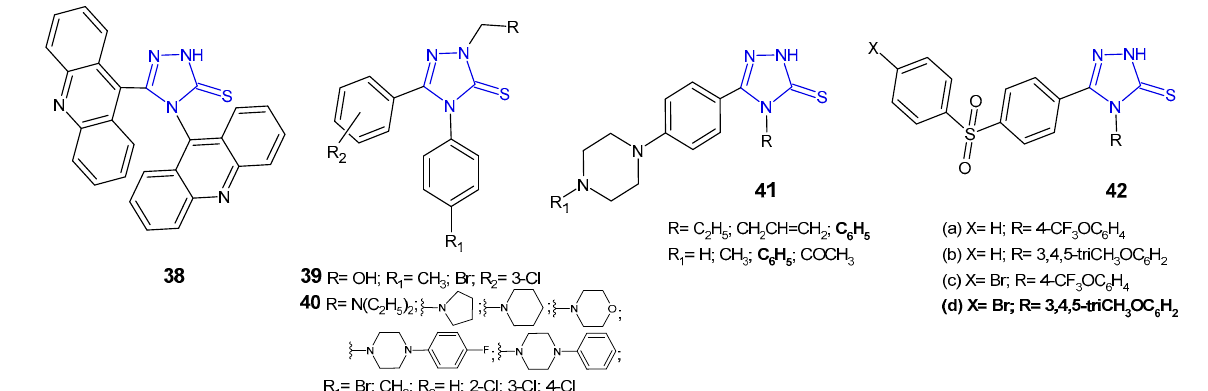
Figure 14. 1,2,4-triazole-3-thiones as antibacterial agents. Plech et al. (2011) prepared N -2-hydroxymethyl 39 and N -2-aminomethyl derivatives